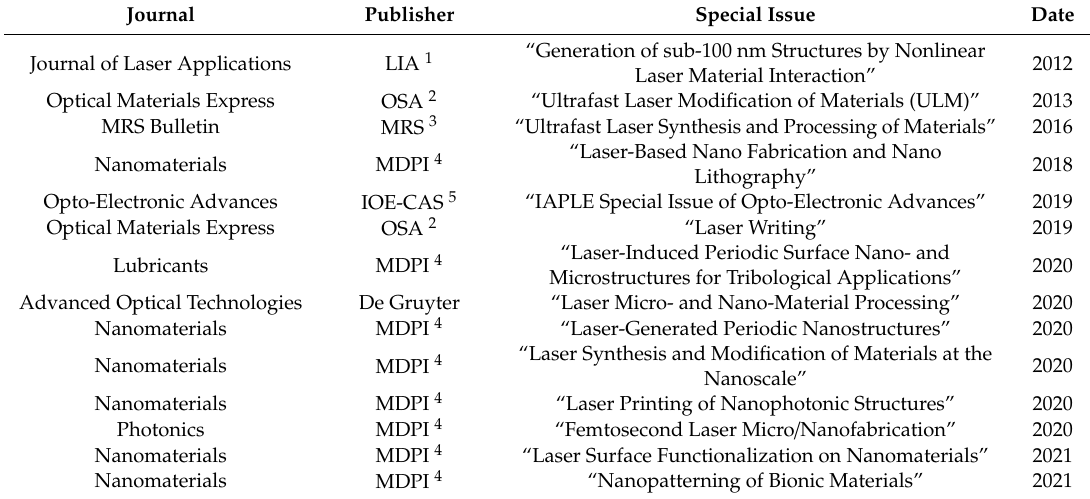
Table 3. Special issues related to LIPSS published in peer-reviewed scientific